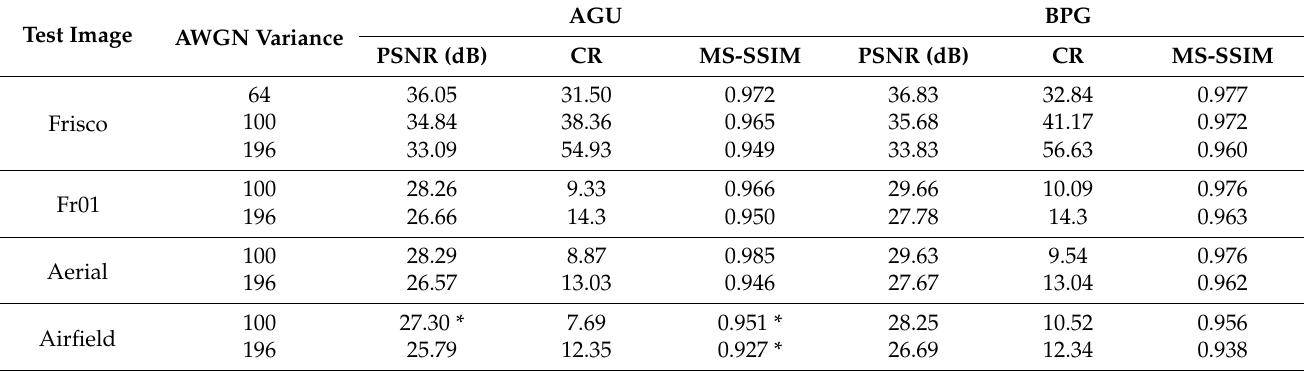
Table 2. Obtained simulation